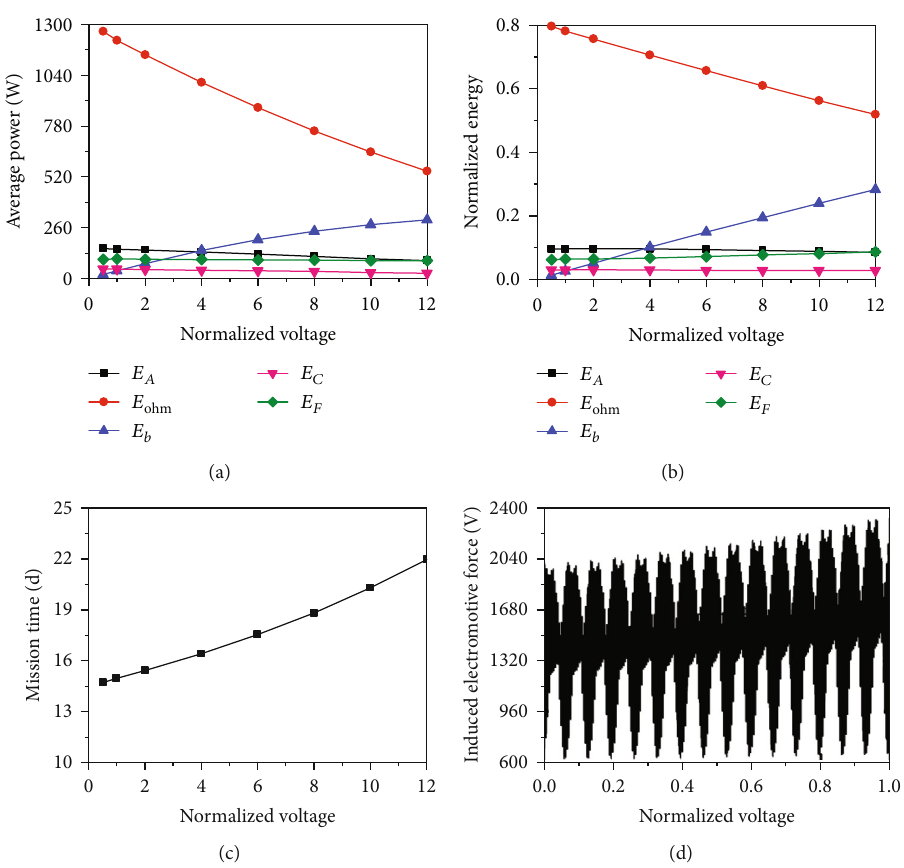
V b ; (b) normalized energy v. b ; (c) mission